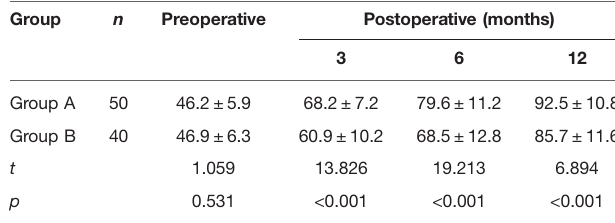
TABLE 3 | Comparison of Harris score between two groups of patients at different time after operation (score, (cid:1) x + S ). Group n